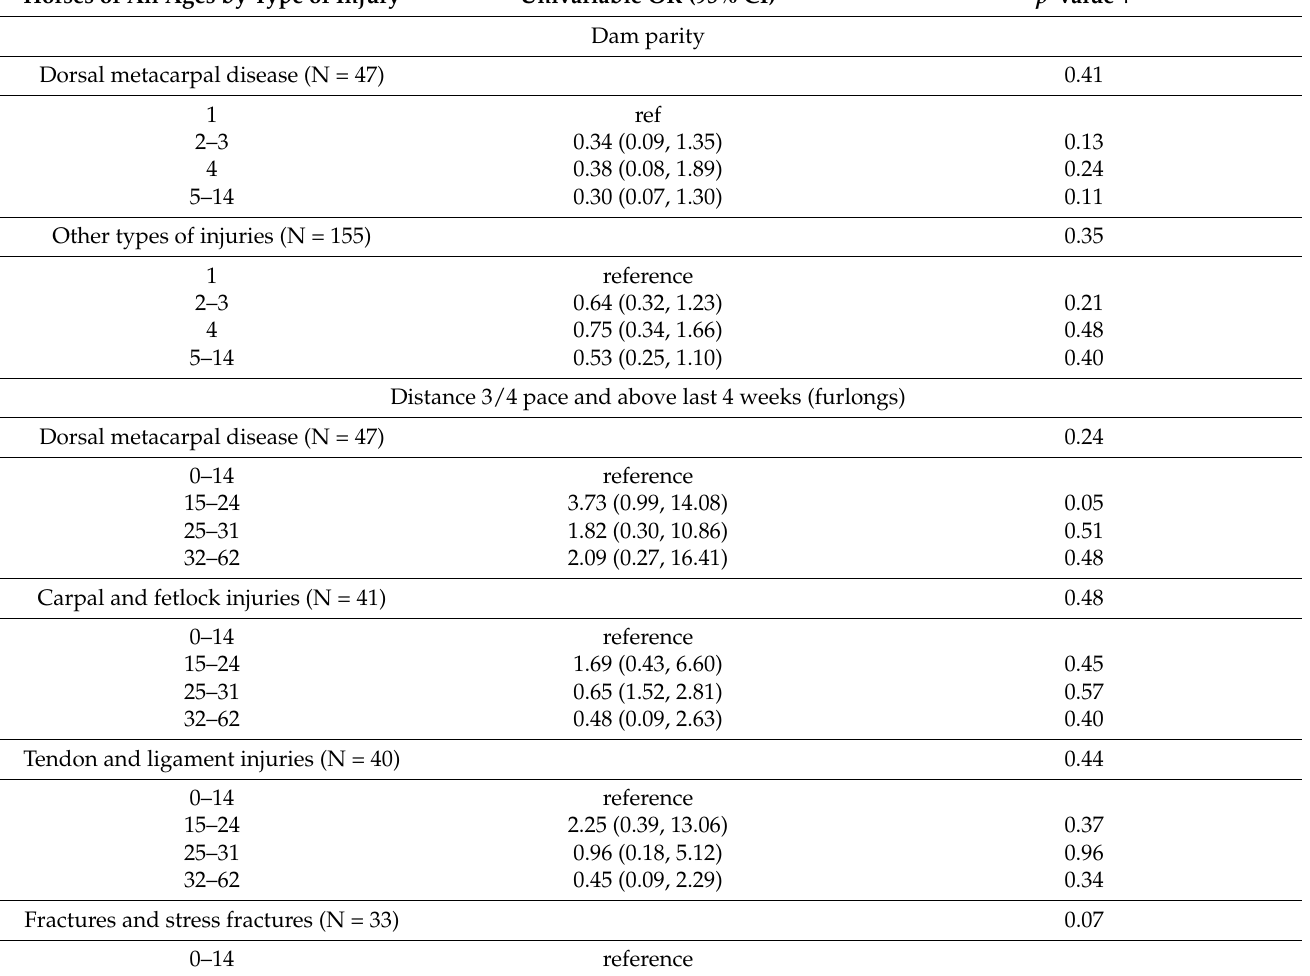
Table A1. The effect of dam parity, the distance travelled at three-quarter pace and above (faster than 13 m/s; 15 s/furlong; 800 m/min; 48 km/h), and the distance travelled at a gallop (faster than 15 m/s; 13 s/furlong; 900 m/min; 55 km/h) in the past four weeks on musculoskeletal injuries, stratified by the broad types of injuries. Horses of All Ages by Type of Injury Univariable OR (95% CI) p -Value † Dam parity Dorsal metacarpal disease (N = 47)